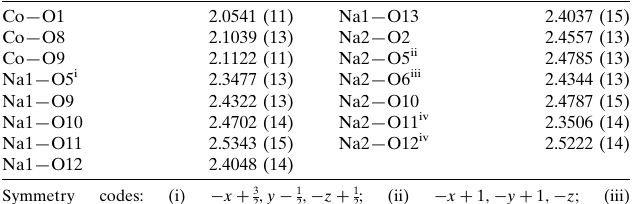
Selected bond lengths (A˚ ).